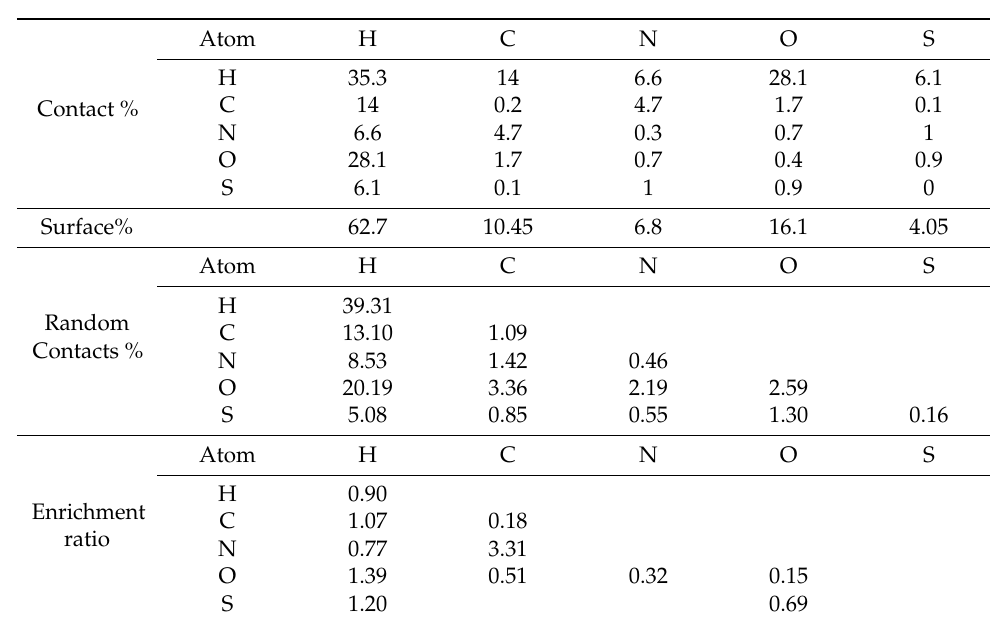
Figure 7. 2D fingerprint plot of interactions and important interatomic contacts in PESMP . Table 3. Enrichment ratio relevant to the pair of chemical species in PESMP . For contacts with less than 0.9% random contact, the enrichment ratio is not